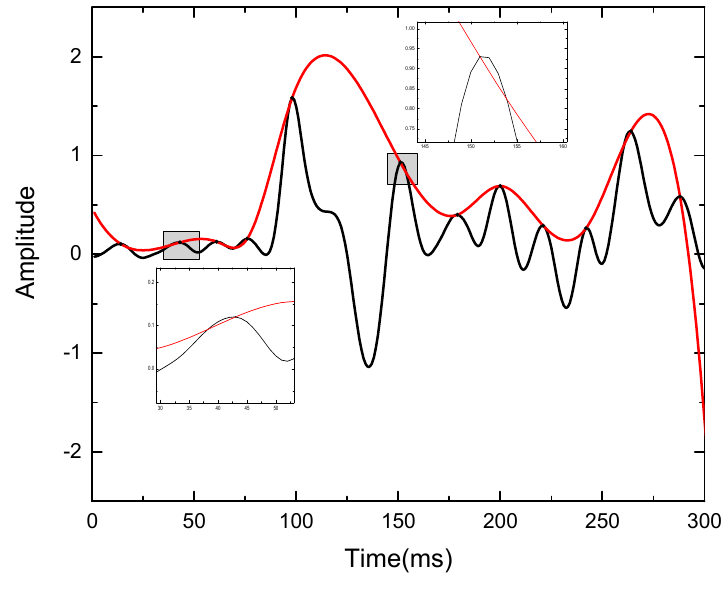
Figure 1. Undershoot phenomenon.